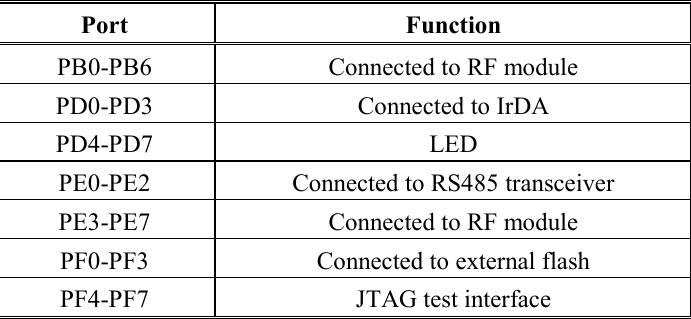
Table 2. Ports assignment of